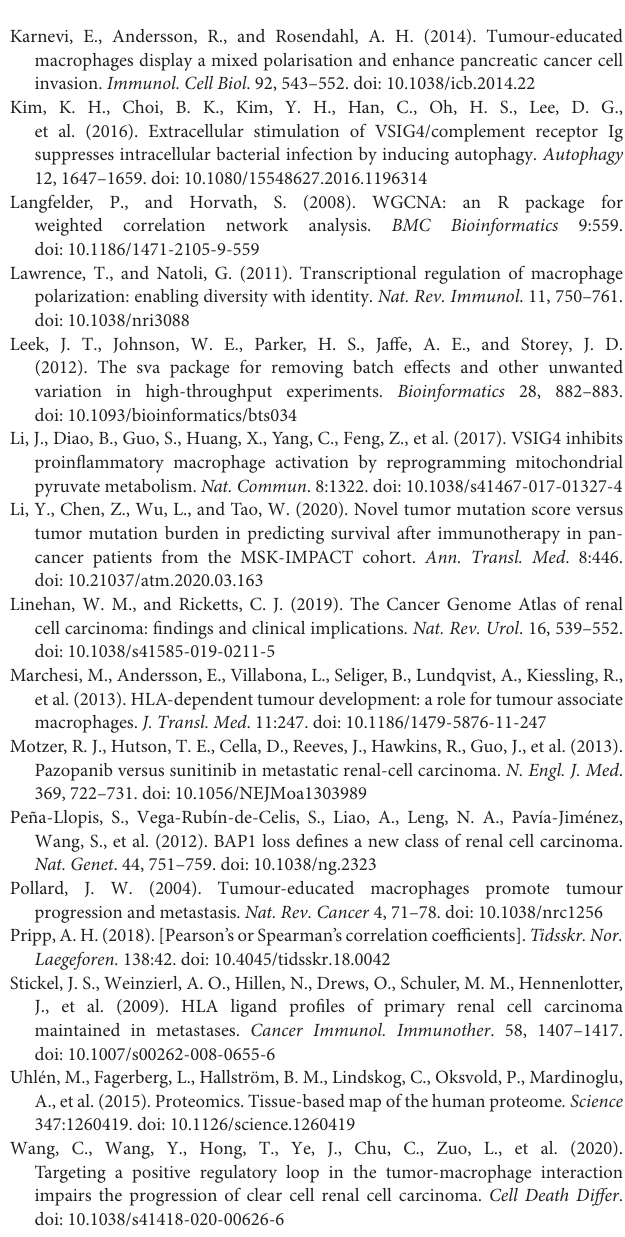
Supplementary Figure 1 | (A) The multi-dataset correction of GSE8050, GSE12606, GSE14762, and GSE36895 using the “sva” package. (B) The verification analysis of M2 related genes in the combined cohorts. Supplementary Table 1 | The detail information of tumor mutation, tumor purity, and M2 macrophage proportion. Supplementary Table 2 | The process data of multi-Cox regression risk score